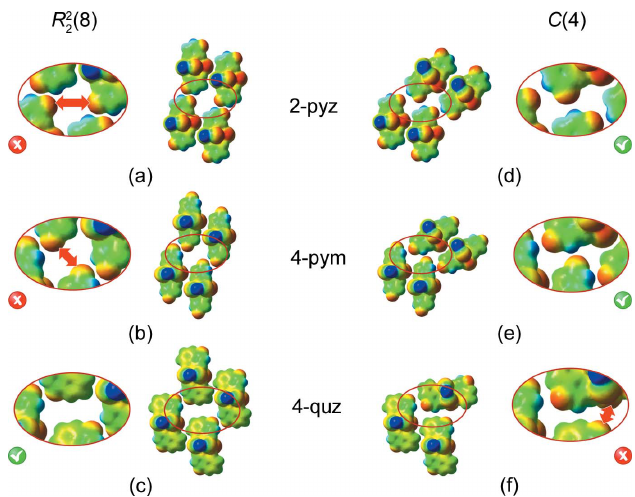
Figure 14 The observed (green ticks) and hypothetical (red crosses) models (assembled starting from one-dimensional coordination polymers repre- sented by one metal centre for clarity) of the pyrazinone- (in compounds 1 – 3 ), pyrimidinone- (in compounds 4 – 6 ) and quinazolinone-based units (in compounds 7 and 8 ) of the single-coordinated cadmium centre for compounds 2 , 5 and 8 ,